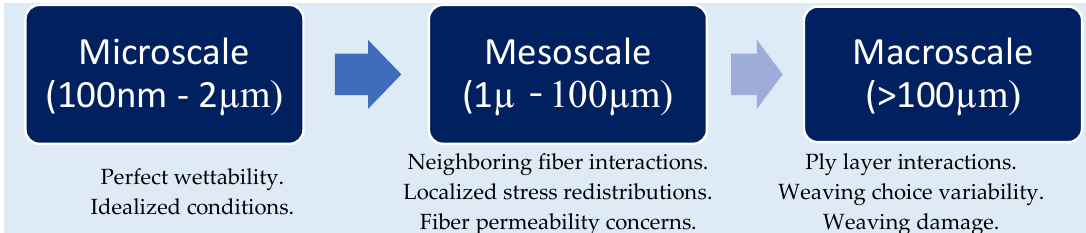
Figure 1. Graphic representing the different scales of testing and introduced testing variabilities.